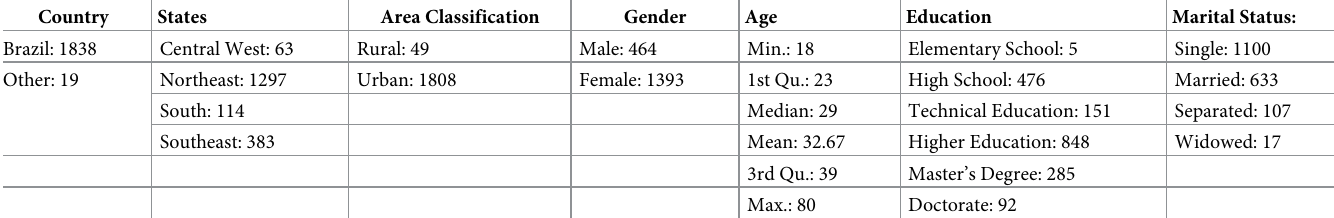
Table 1. Demographic profile of the final sample. Country